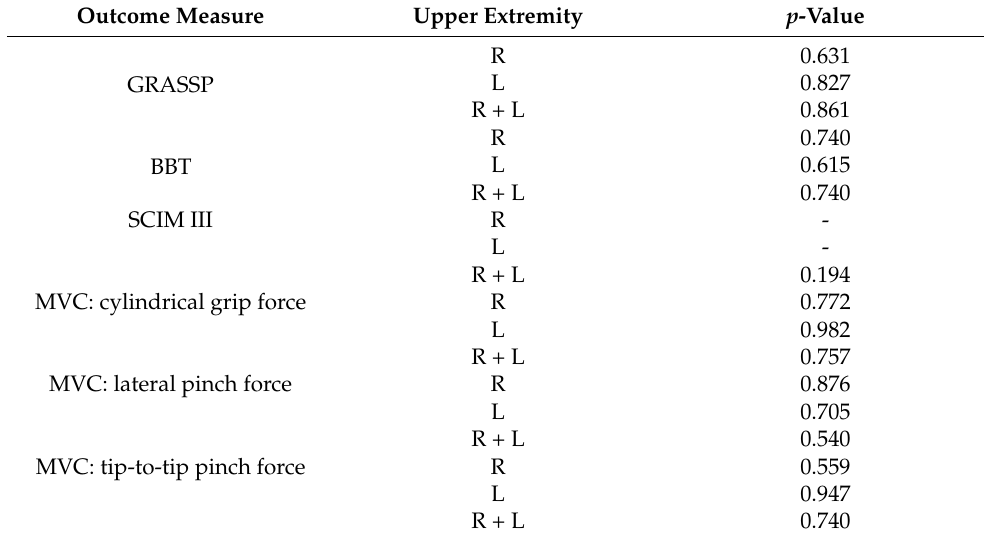
Table 2. The p -value of different functional assessments between both groups pre-intervention condition.